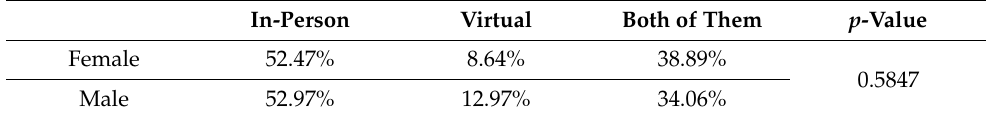
Table 1. Dimension or environment where you feel freer to express your identity.